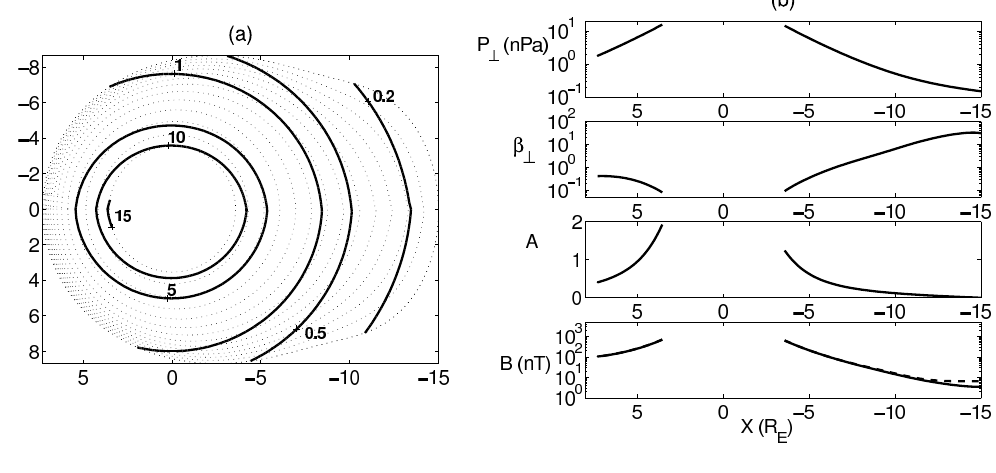
Fig. 10. (a) Contours of constant P ⊥ in the equatorial plane; (b) Profiles along the Sun-Earth axis for: perpendicular pressure P ⊥ , perpen- dicular β ⊥ , degree of anisotropy A = P ⊥ /P k − 1, and magnetic field magnitude B ; the dashed line in the bottom plot represents B from the T01